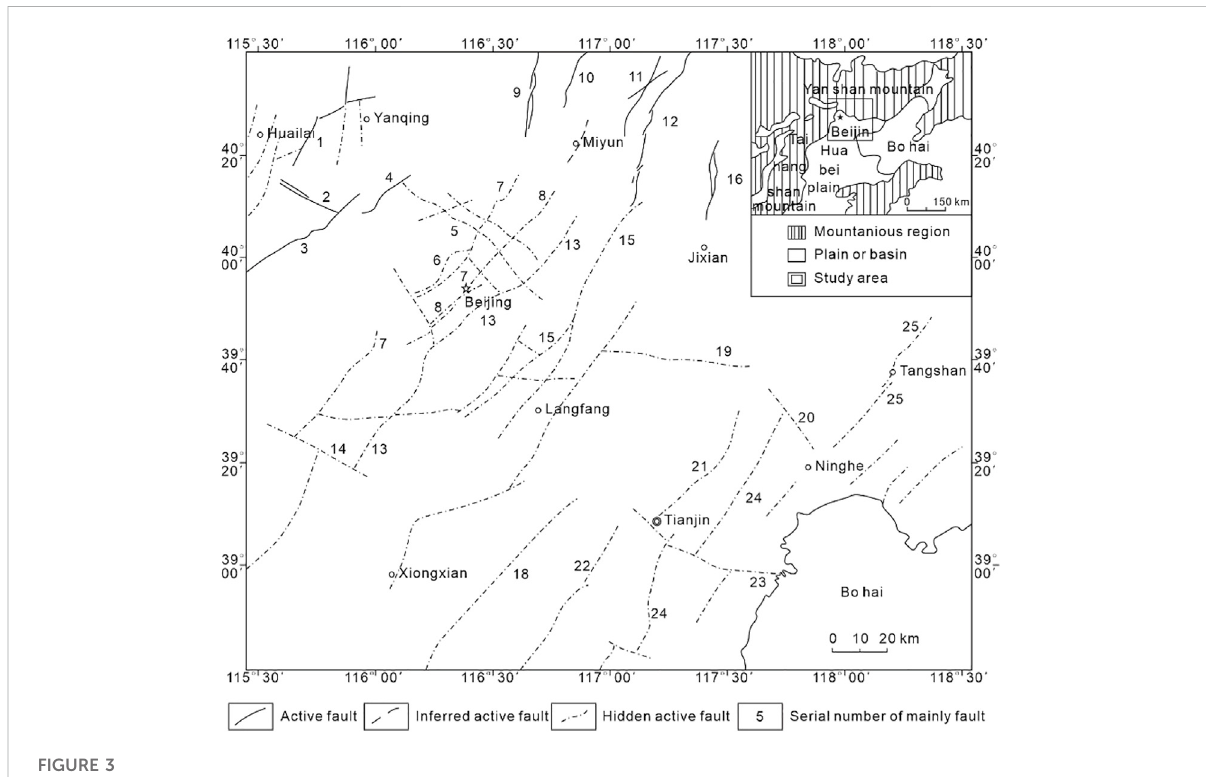
FIGURE 3 Distribution of active faults in Beijing and Tianjin